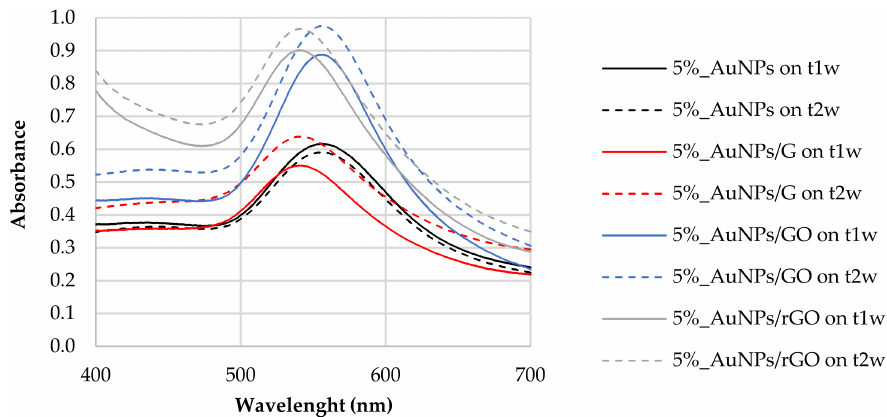
Figure 8. AuNP samples stability (t 1w –t 2w ). Carbon-based nanomaterials added after AuNP